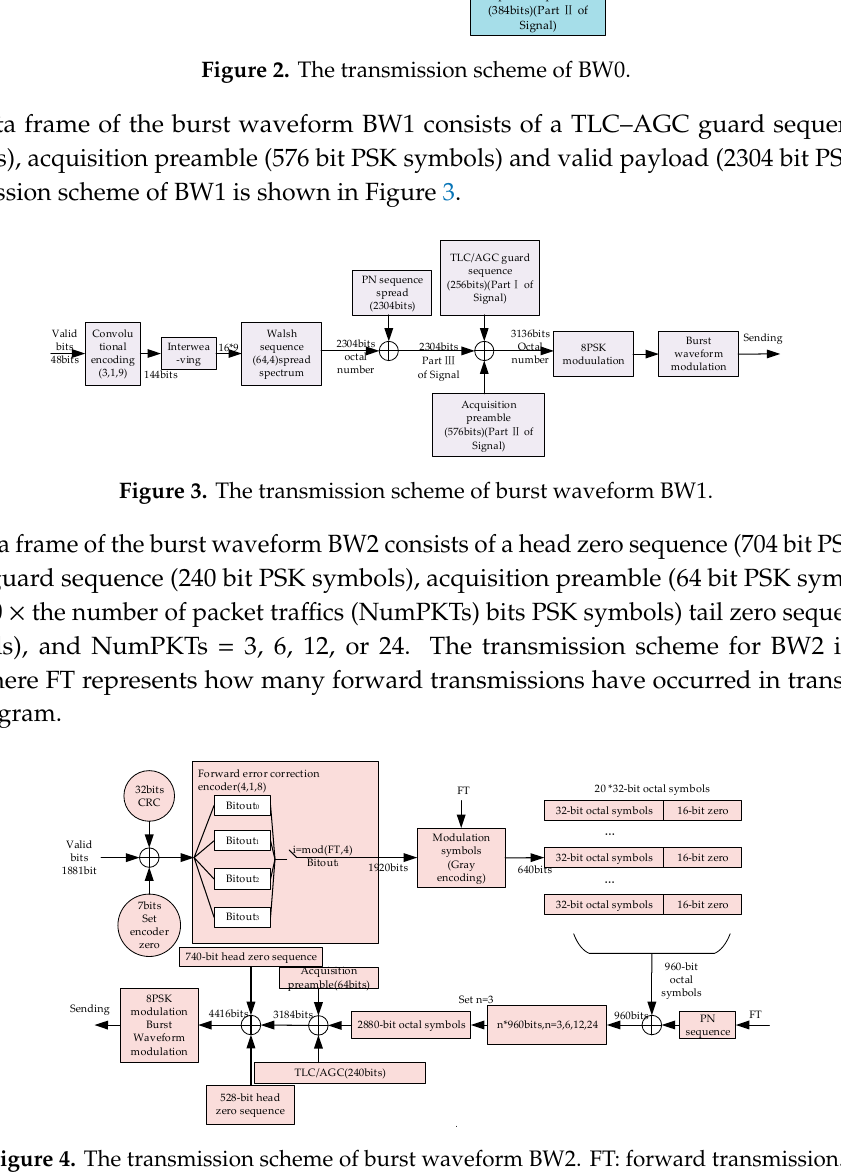
Sending Figure 5. The transmission scheme of burst waveform BW3. The data frame for burst waveform BW4 consists of an acquisition preamble (256 bit PSK symbols) and valid payload (2 bit PSK symbols). The transmission scheme for BW4 is shown in Figure 6. Walsh sequence (16,2) Soft spread spectrum